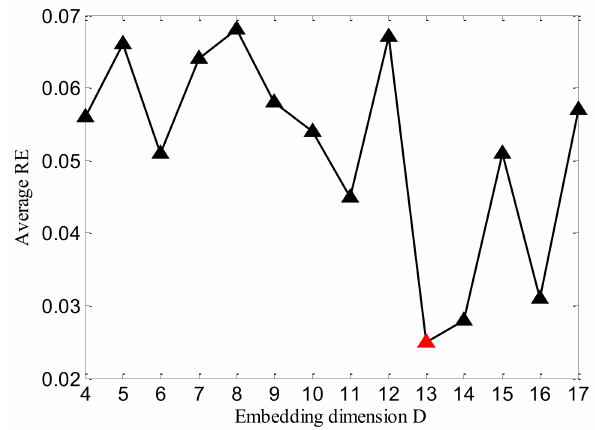
Figure 3. The influence of D on prediction